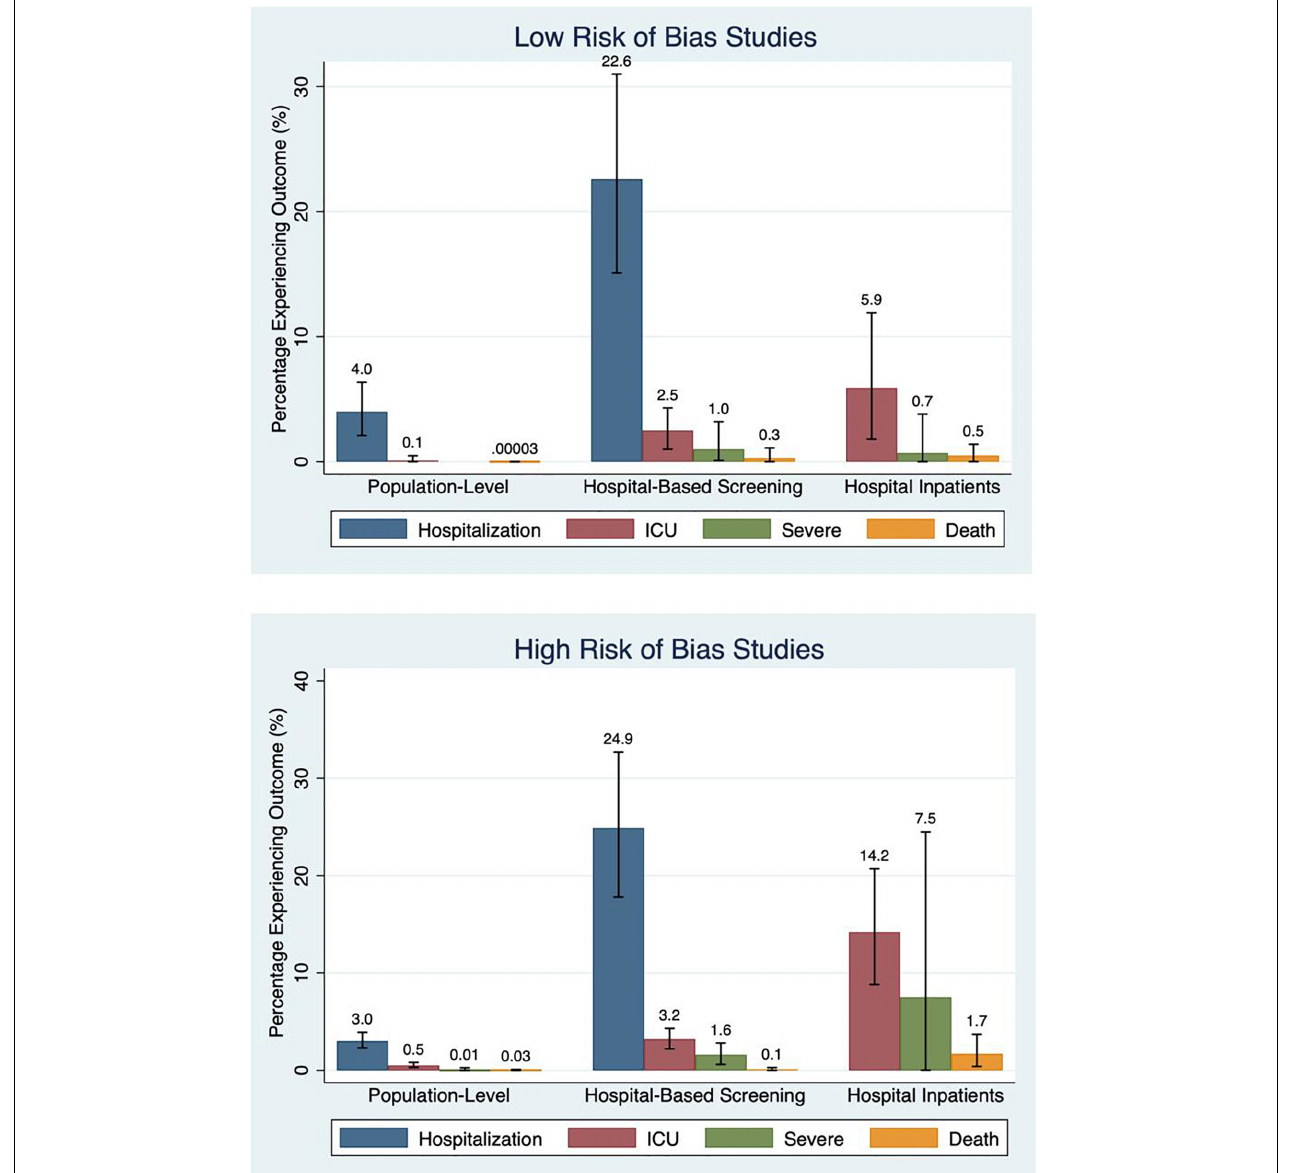
FIGURE 7 | Percentage experiencing outcomes by risk of